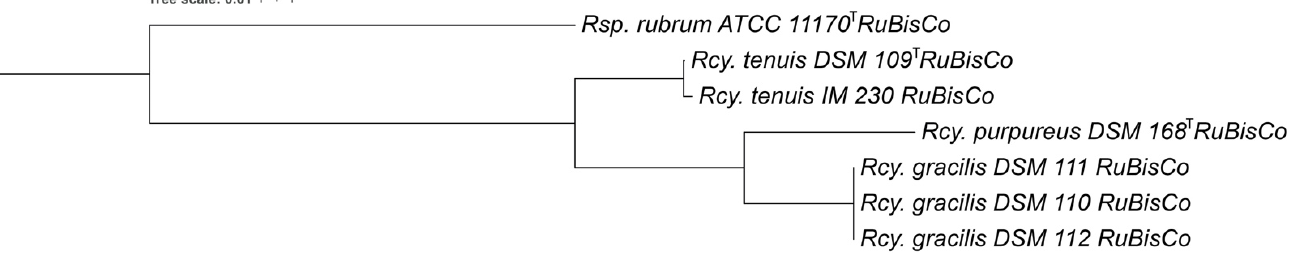
Figure 6. Phylogenetic tree based on multiple sequence alignment of the RuBisCo protein sequences, obtained from the Rhodocyclus genomes (PGFam_00048972). Rhodospirillum rubrum ATCC 11170 T RuBisCo was added as an outgroup.